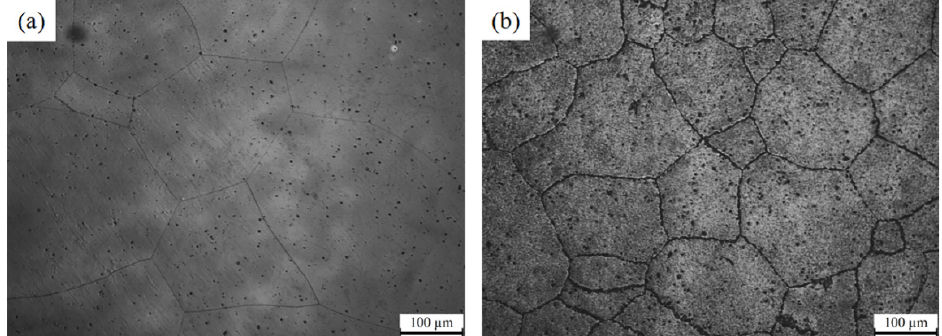
Figure 1. The OM images of as-cast LAZ13 xy ( x = 3, 6 wt%, y = 3, 6 wt%) alloys: ( a ) LAZ1333, ( b ) LAZ1366. Table 1. The EDS results of the second phases marked by the yellow arrows and letters in Figure 2. Chemical Compositions Positions